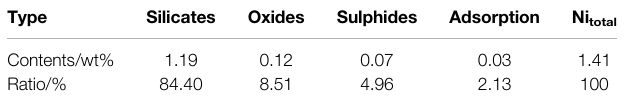
TABLE 2 | Nickel distribution state of the studied